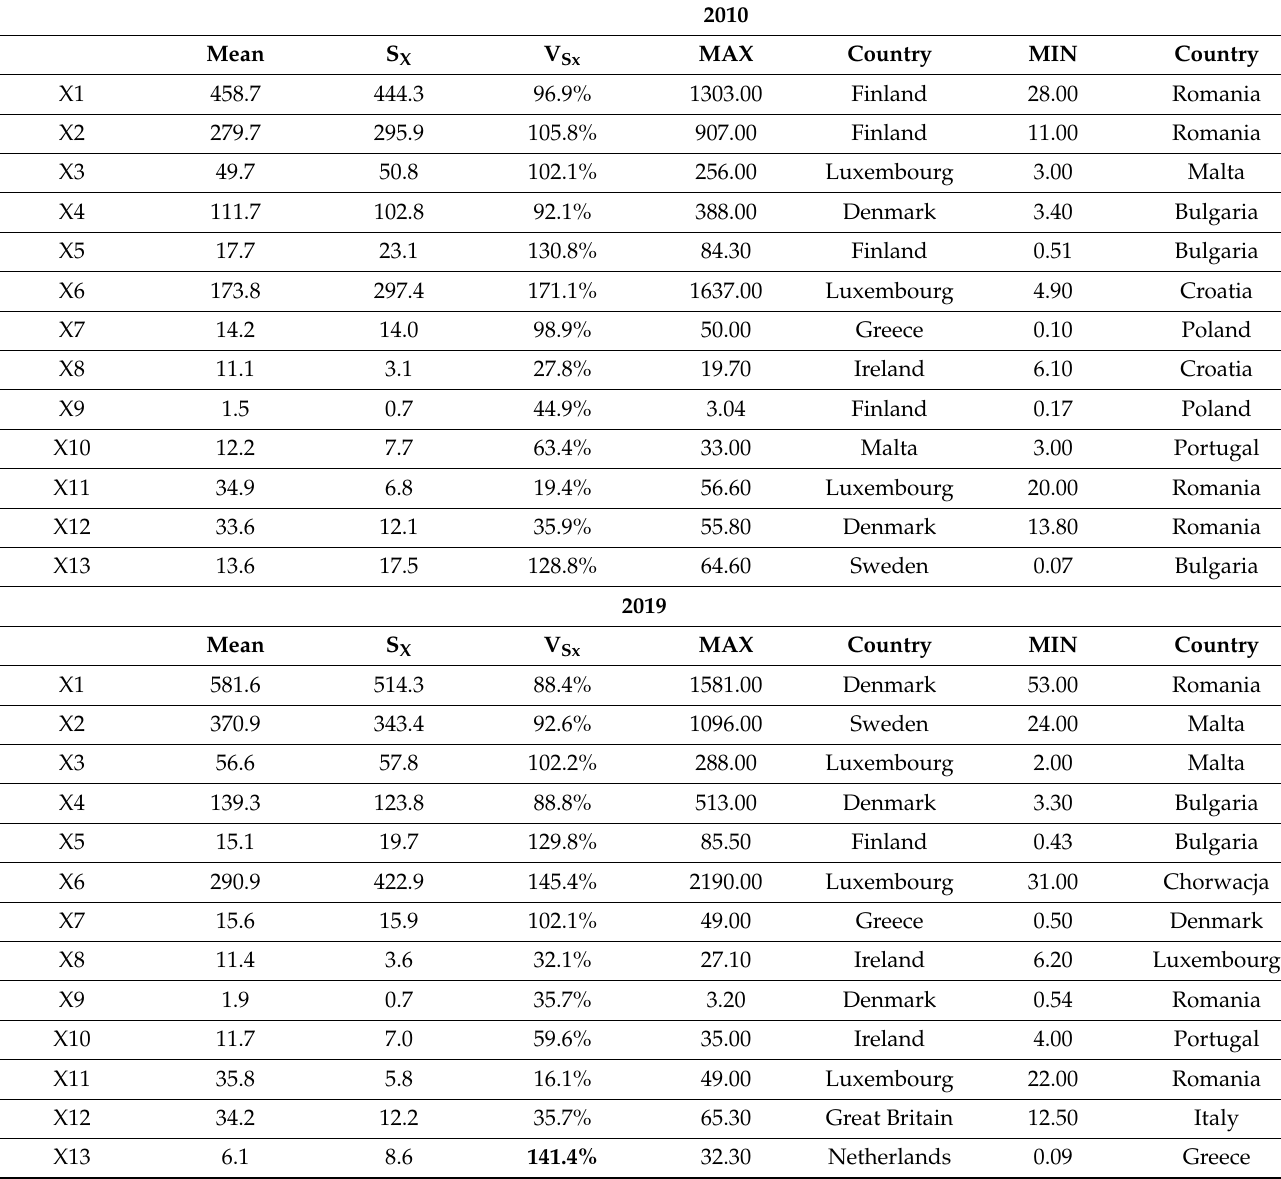
Table 4. Comparison of selected measures of descriptive statistics in total in 2010 and